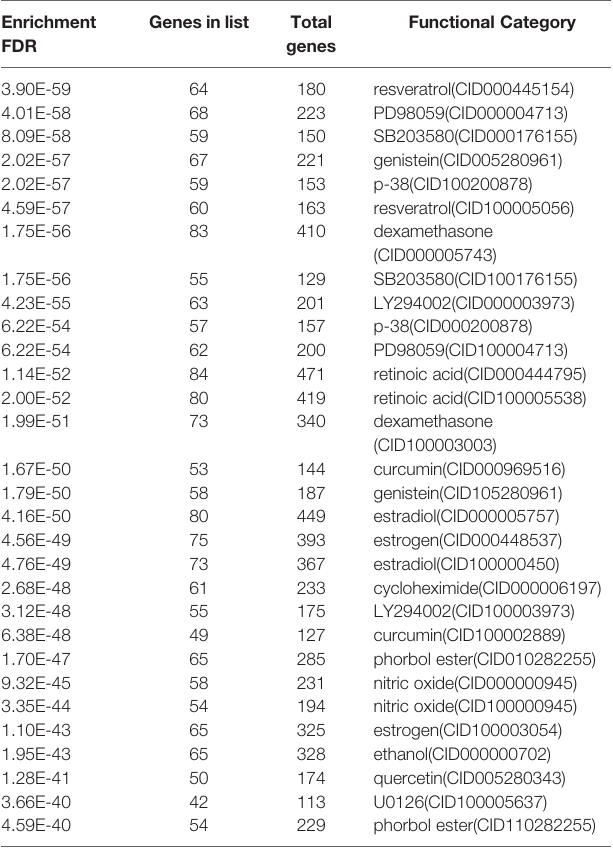
TABLE 2 | List of suggested agents for COVID-19 and dengue